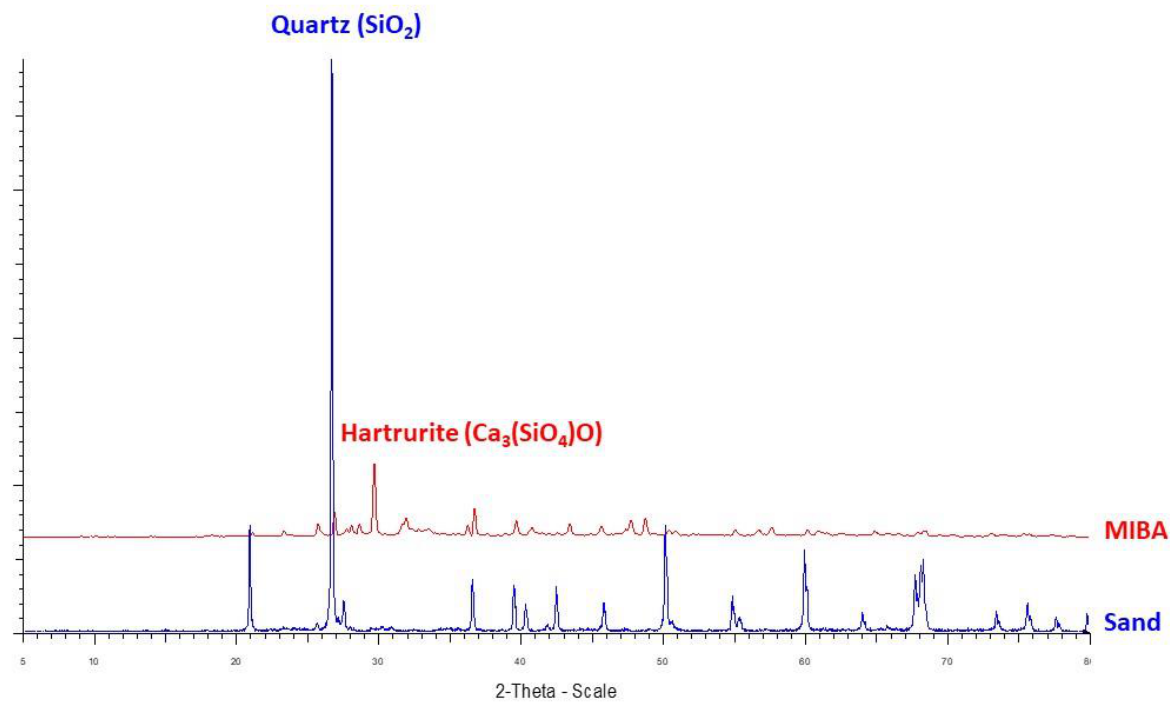
Figure 3. X-ray diffraction patterns of sand and MIBA.